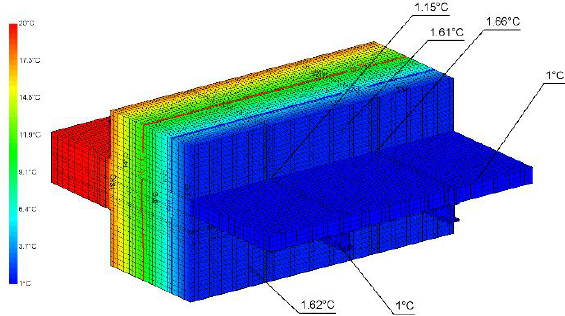
Figure 18. External surface temperature distribution field on the wall and balcony slab—top view.